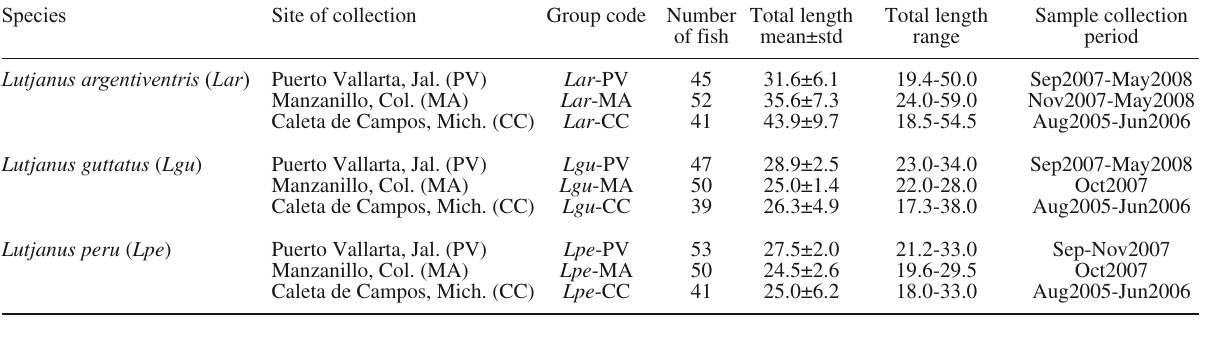
Table 1. – Size of sample and site of collection of fish scales: Lar = Lutjanus argentiventris ; Lgu = L. guttatus ; Lpe = L. peru .